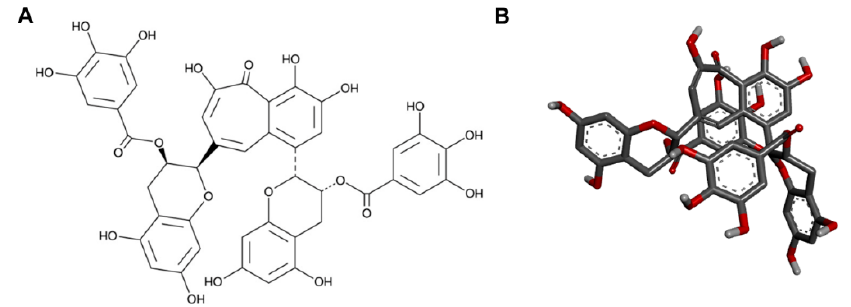
Figure 1. The ( A ) 2D and ( B ) 3D chemical structures of TFDG.